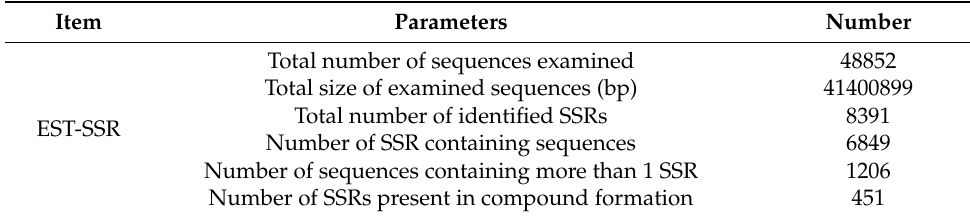
Table 1. Summary of analyses of expressed sequence tag-simple repeat (EST-SSRs) in E. indica